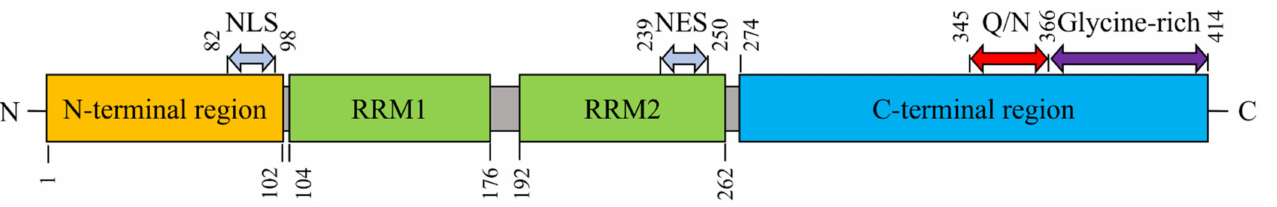
Figure 1. The structure of TAR DNA-binding protein 43 (TDP-43) protein. TDP-43 is com- posed of an N-terminal region, two RNA recognition motifs (RRM1 and RRM2), a nuclear local- ization signal (NLS), a nuclear export signal (NES), and a C-terminal region (with a prion-like glutamine-/asparagine-rich [Q/N] region and a glycine-rich region). The numbers represent amino acid